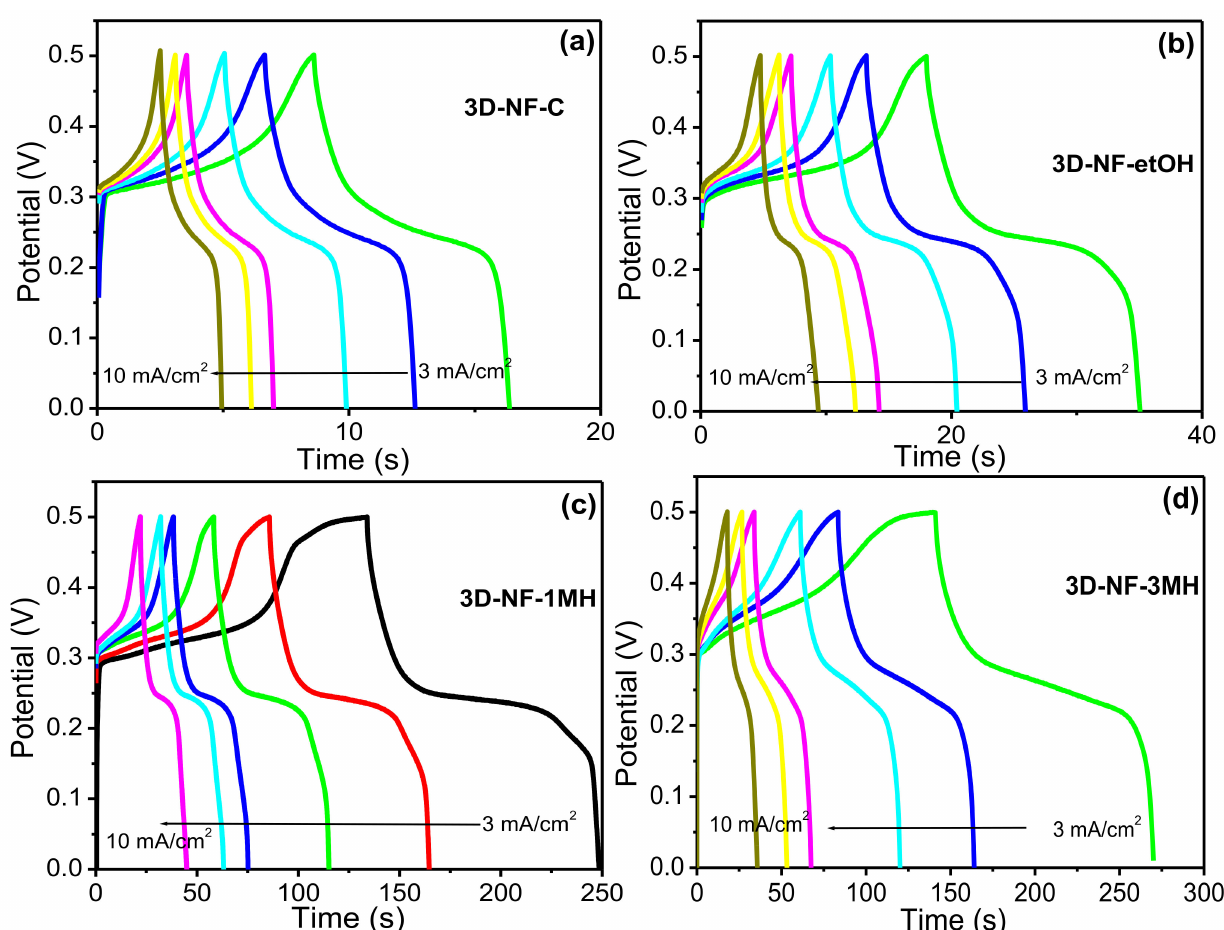
Figure 5. CD graph of the ( a ) 3D-NF-C; ( b ) 3D-NF-etOH; ( c ) 3D-NF-1MH; and ( d ) 3D-NF-3MH electrodes at different current